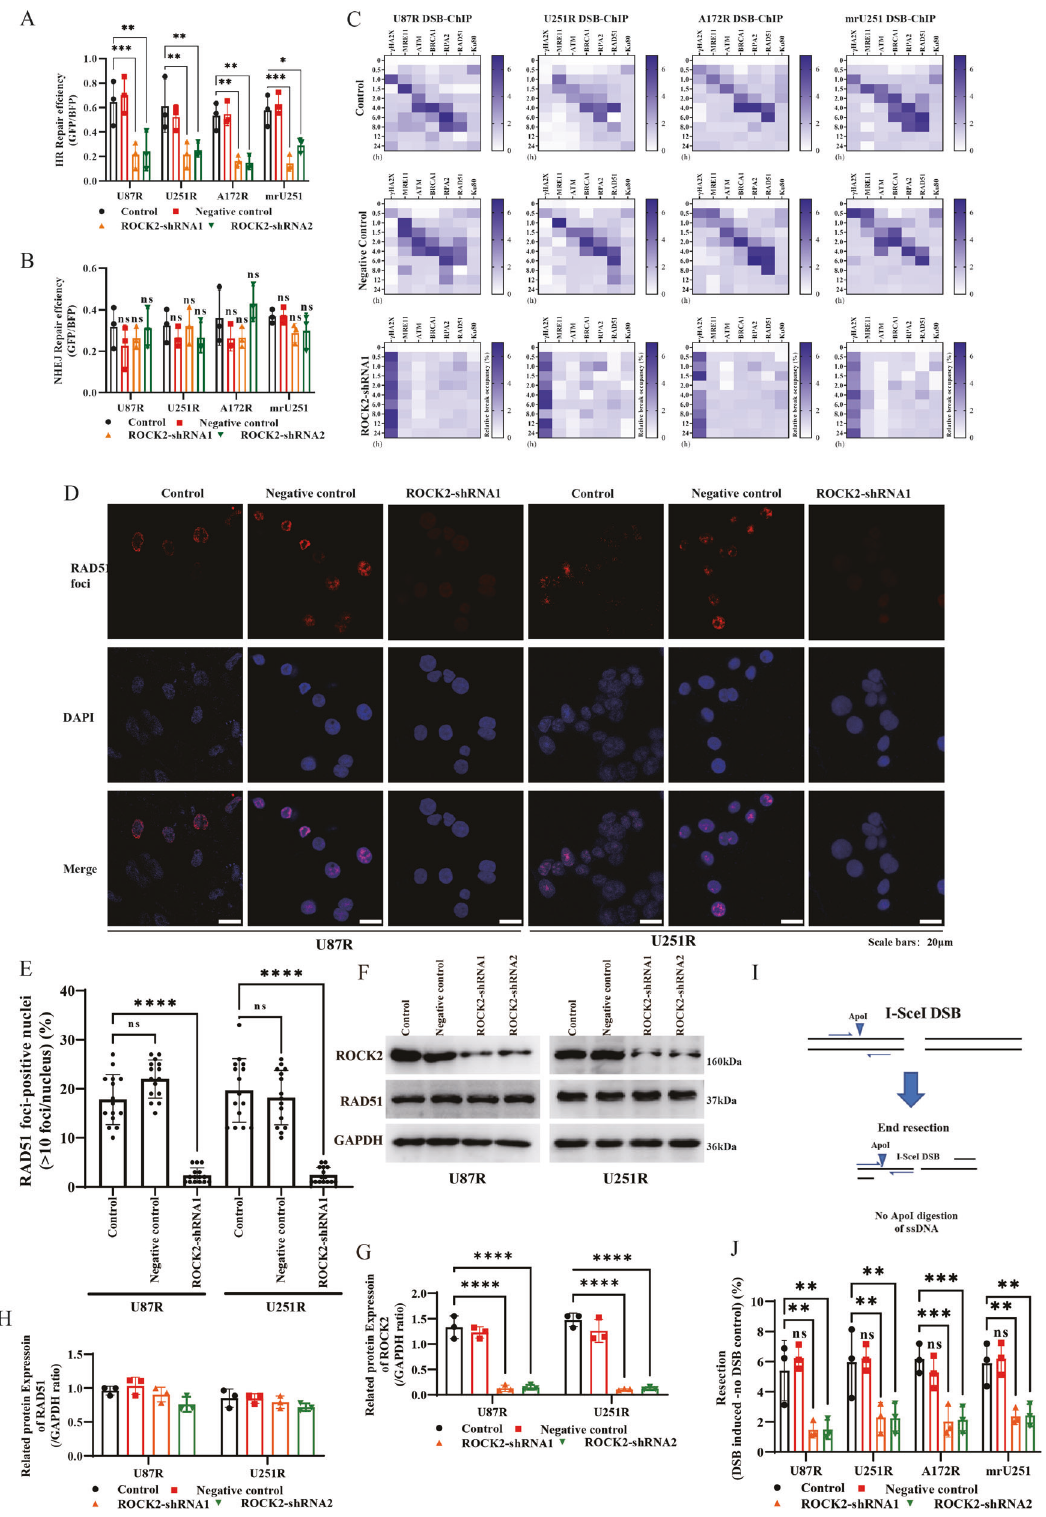
Fig. 3 ROCK2-KD suppressed stepwise recruitment of HR factors to DNA DSBs. A , B ROCK2-KD suppressed HR repair. C – F Heat maps of relative occupancy of indicated factors at site-directed DSB with ROCK2-KD. G Immuno fl uorescence images of RAD51 in cell nuclei in the indicated cells with TMZ (100 μ M), Scale bars, 20 μ m. H Quanti fi cation of RAD51 foci-positive nuclei. I Schematic representation of PCR-based DNA end-resection assay. J Quanti fi cation of end-resection at the same site-speci fi c DSB as used in the DSB-ChIP assay. Data are expressed as mean ± SD. p values determined by ANOVA or two-tailed unpaired t -test. Statistical differences compared with the controls are given as * p < 0.05, ** p < 0.01, *** p < 0.005, **** p < 0.001.